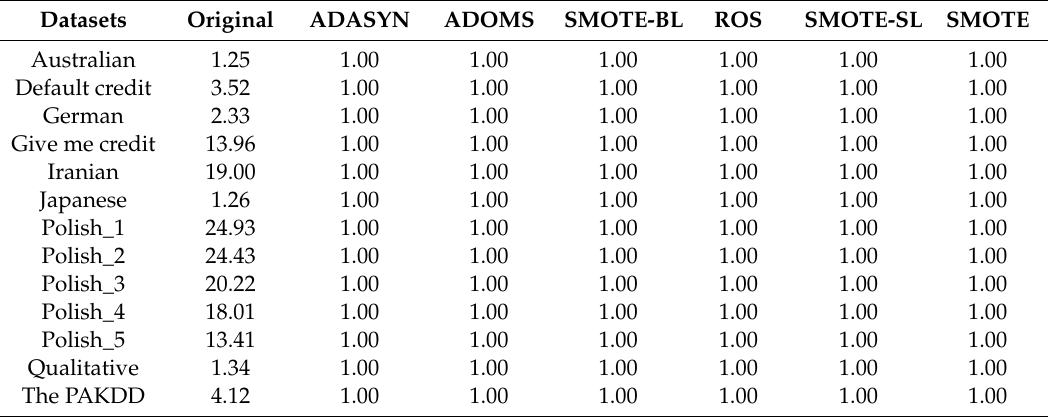
Table 6. Imbalance ratio for oversampling